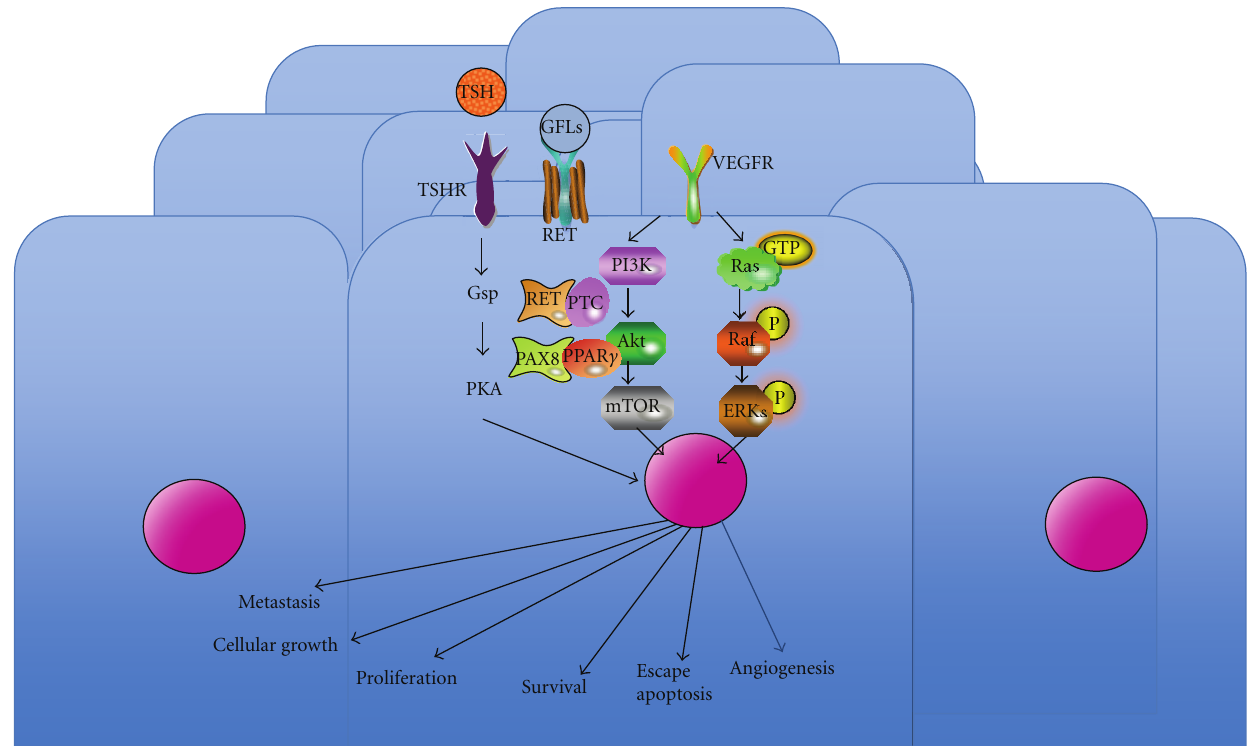
Figure 2: Schematic representation of the follicular tumor